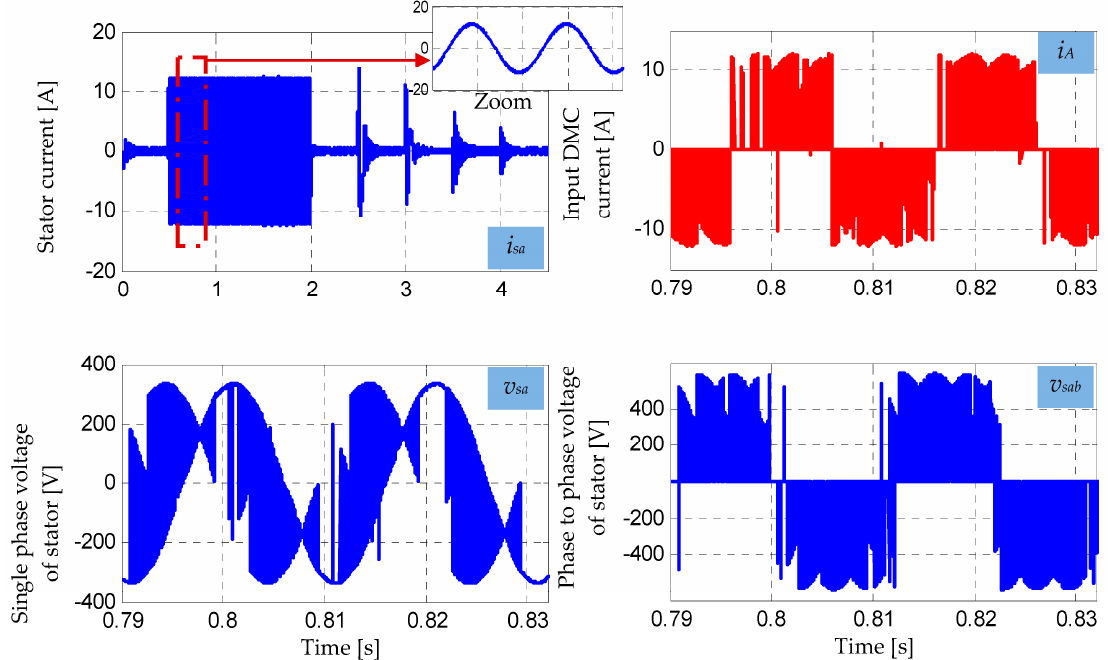
Figure 7. Waveforms of stator current, single and phase to phase voltage, and input current of DMC.